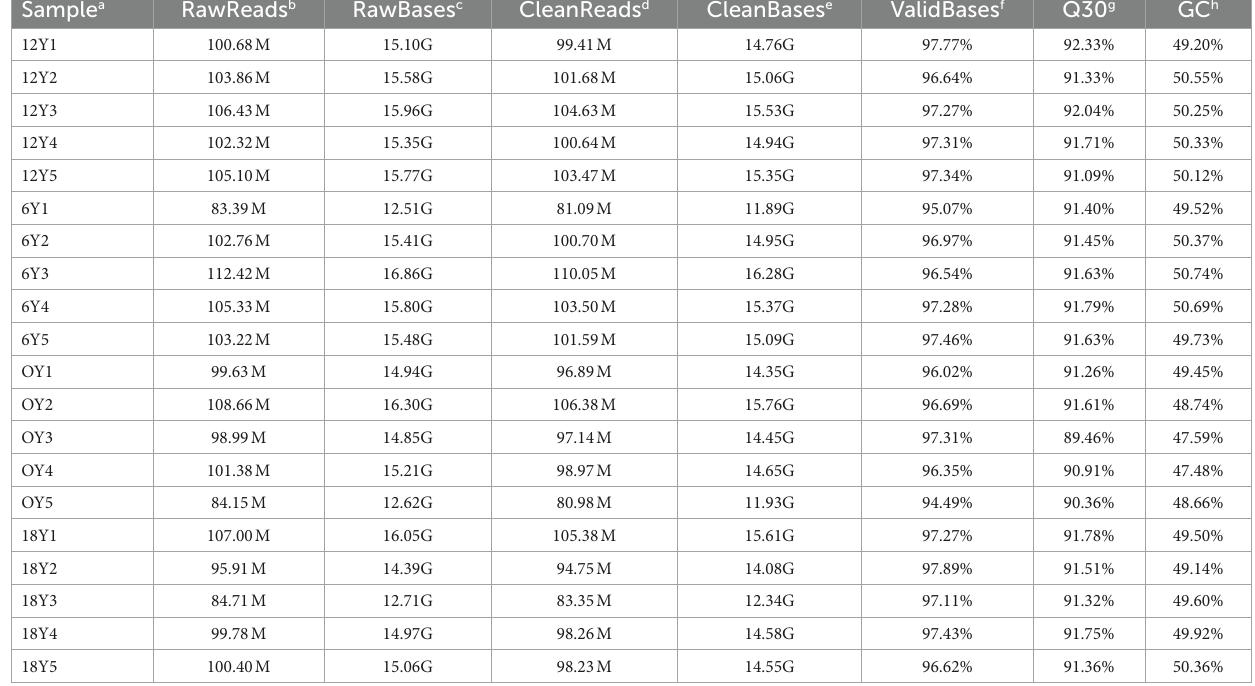
TABLE 3 CircRNA sequencing